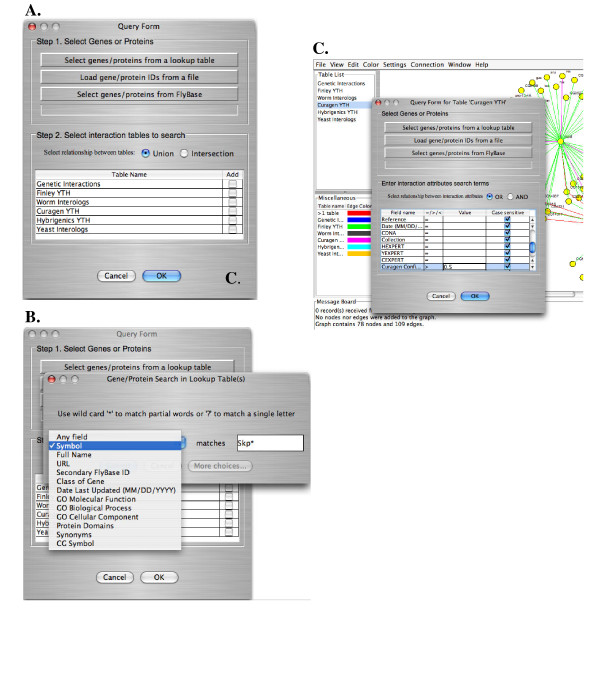
Examples of ways to query the database with IM Browser. (A) The query form for adding new interactions to an existing graph, drawing a new graph, finding nodes to color, or applying filters to an existing graph. In Step 1, genes or proteins are selected to be used in a search of the interaction database. To select genes or proteins, gene identifiers (IDs) or wild-cards (*) can be entered or looked up from either Flybase or a lookup table based on gene/protein attributes. A text file of gene IDs can also be uploaded. In Step 2, the interaction data tables to search are selected by checking boxes in the lower half of the window, and the relationship (Union or Intersection) between the interaction tables is specified. (B) Searches can be performed on any or all attributes in the gene/protein information or "look up" table(s). All of the attributes from these tables are listed and searchable; attributes in newly added tables are dynamically added to the list. (C) Individual interaction tables can also be searched to find new interactions or to apply filters to an existing interaction map. All of the attributes in each interaction table are searchable with operators ('=', '<', '>'), and the relationship ('AND', 'OR') between attributes can be specified by the user. In the example, a search of the 'Curagen YTH' table for interactions with a confidence score >0.5 is about to be initiated.